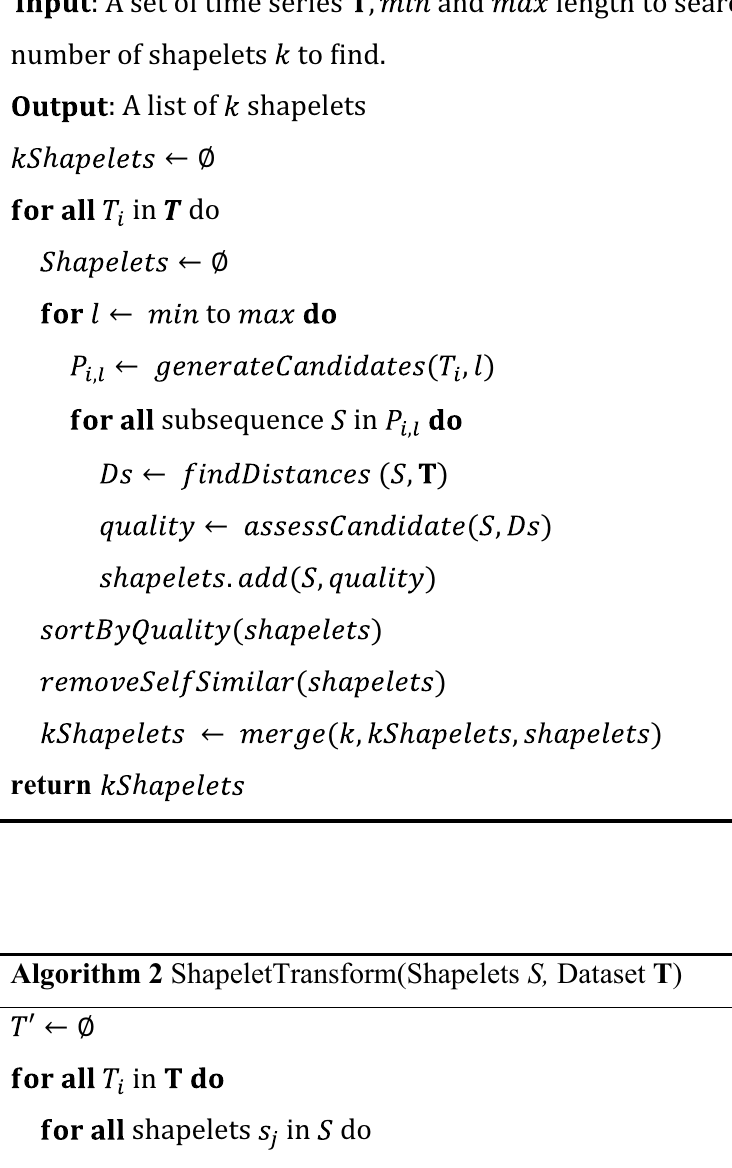
Algorithm 1 ShapeletSelection( T ,